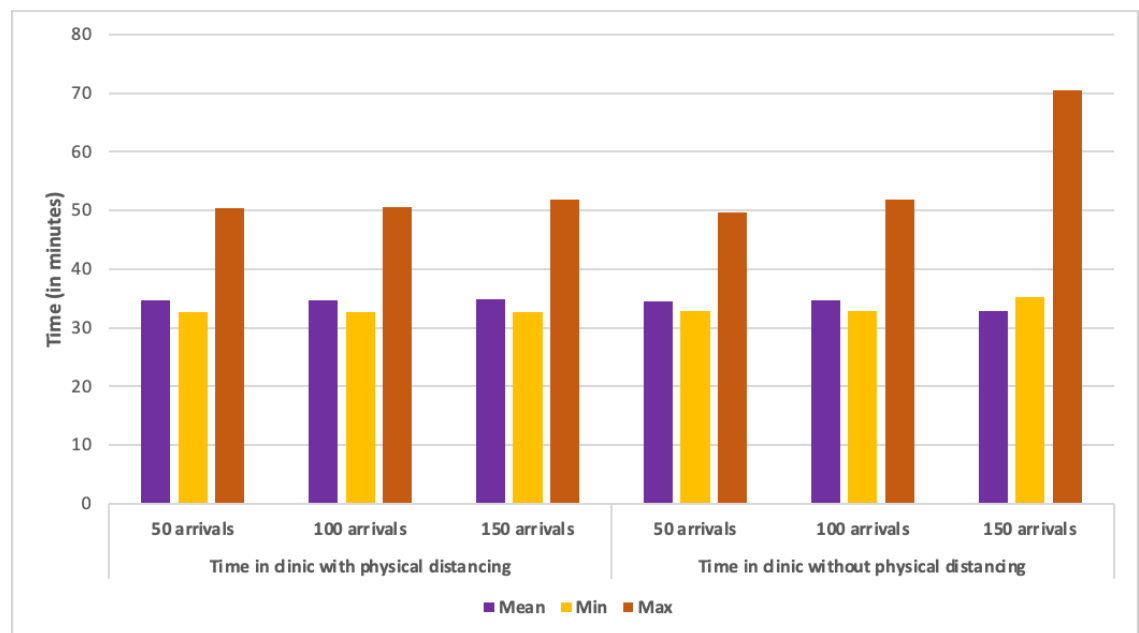
Figure 6. Average time spent waiting by clients at each of the arrival rates for a facility with physical distancing measured in minutes.